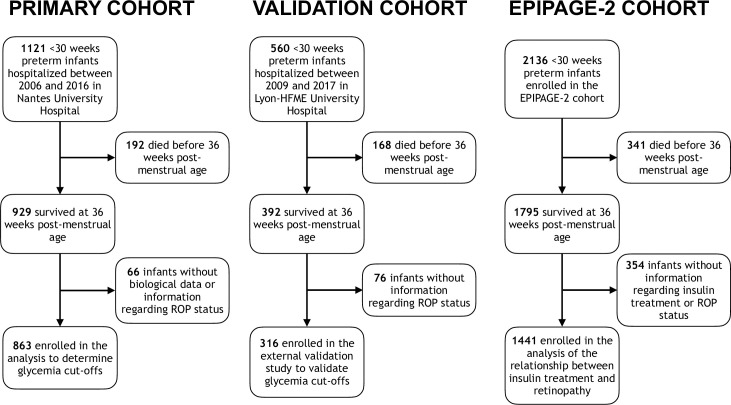
Flow diagram of the 3 study populations.ROP, retinopathy of prematurity.